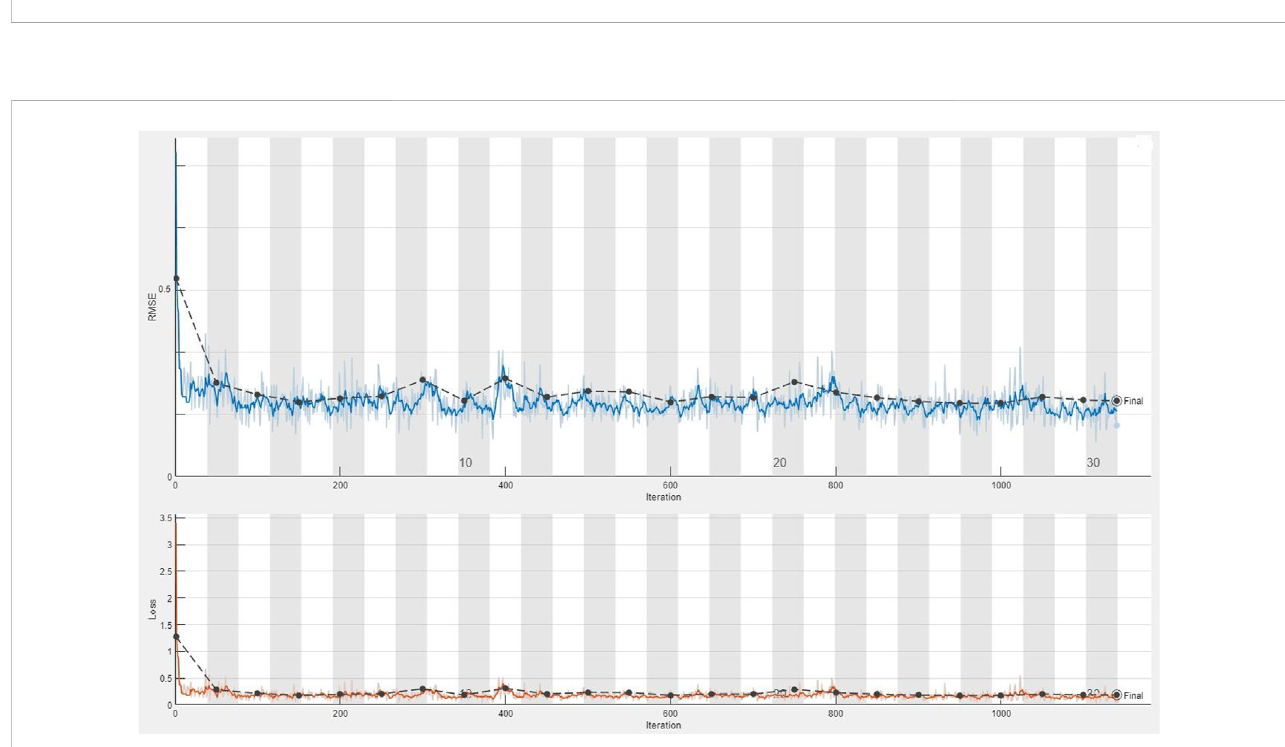
FIGURE 8 Plot of the fourth training of the dataset applying the CDL network for calculating the loss value and RMSE parameter from the second stage regimentation of the second group (Ag – Cd –